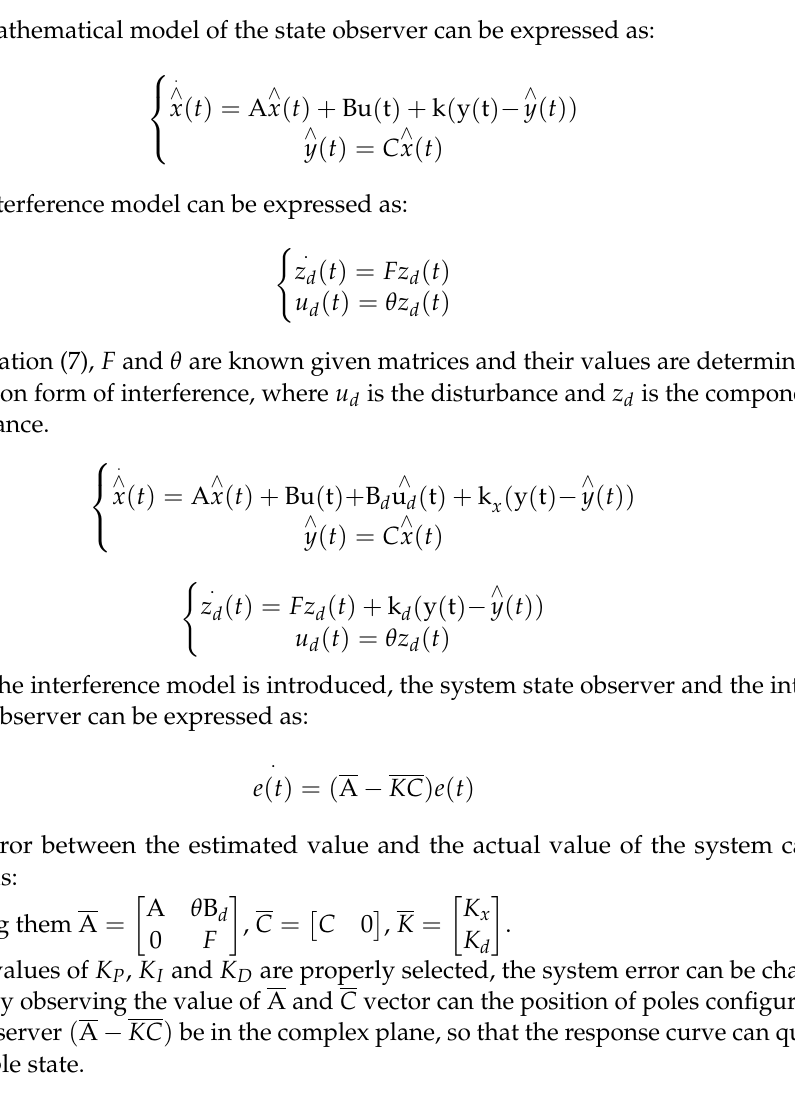
Figure 3. Schematic diagram of disturbance adaptive control of PID state feedback.